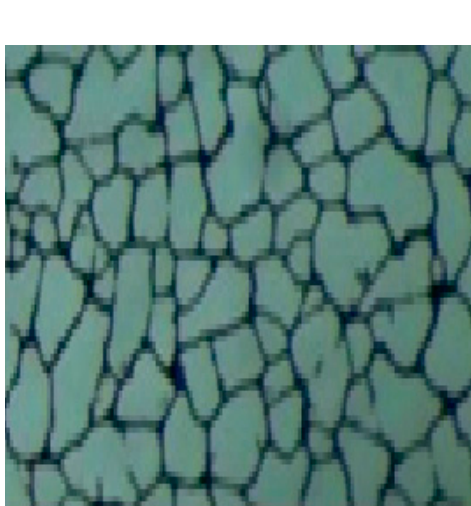
Figure 1. MMMC film viewed through microscope.